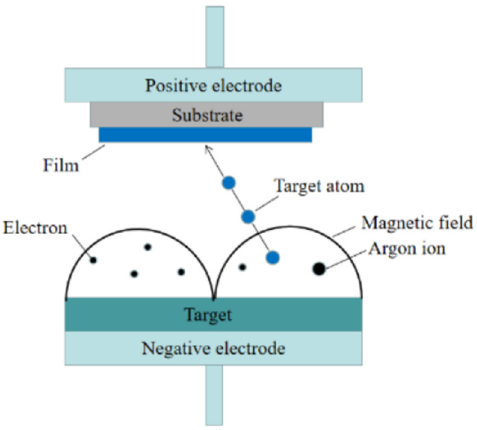
Figure 1. Schematic diagram of magnetron spuering method.